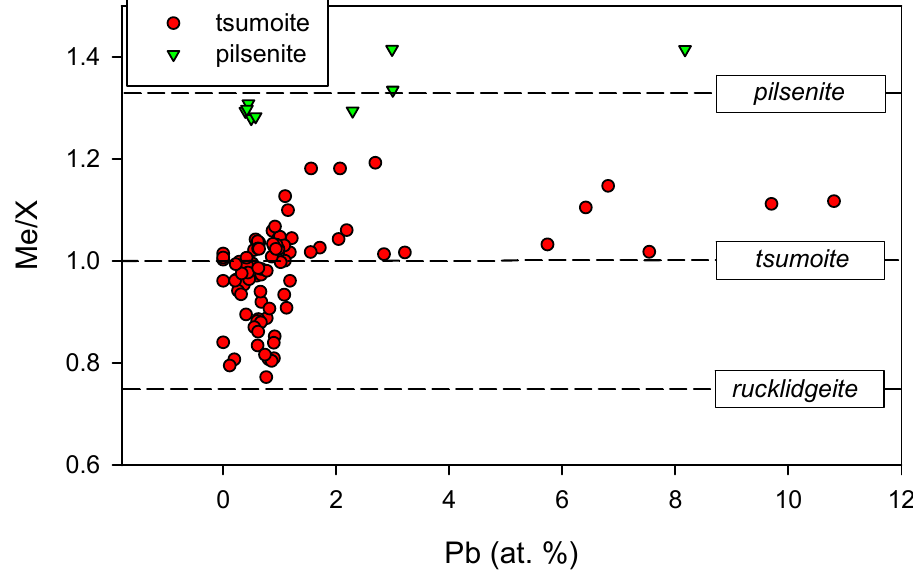
Figure 12. Chemical composition of tsumoite and pilsenite in a Pb (at. %) versus Me/X ratio plot.